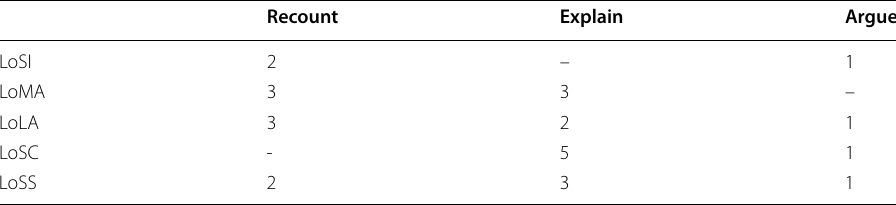
Table 3 Bivariate frequency of attributes in the final standards-based Q -matrix Recount Explain